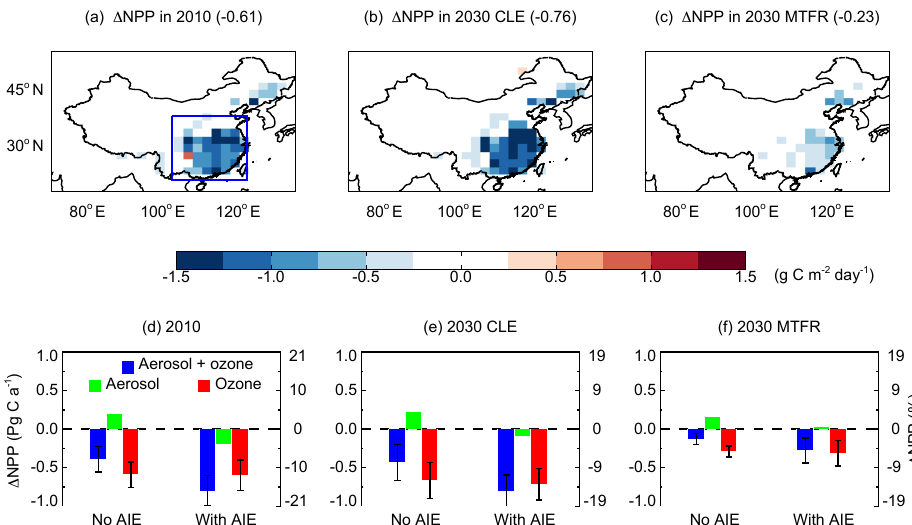
Figure 10. Impacts of air pollution on NPP in the whole of China. Results shown are combined effects of aerosol and O 3 on the summer NPP in (a) 2010, (b) 2030 with CLE scenario, and (c) 2030 with MTFR scenario. Results for the top panels do not include aerosol indirect effects (AIE) but do include the meteorological response to aerosol direct radiative effects. The average NPP perturbation over the box domain in panel (a) is shown in the bracket of each title. The perturbations to annual total NPP by aerosol, O 3 , and their sum over the whole China are shown in panels (d–f) for different periods, with (right) and without (left) inclusion of AIE. Damages by O 3 are averaged for low and high sensitivities with error bars indicating ranges. The percentage changes are calculated based on NPP without AIE. Simulations are performed with the ModelE2–YIBs model. Only the significant changes ( p <0.05) are shown in panels (a–c)